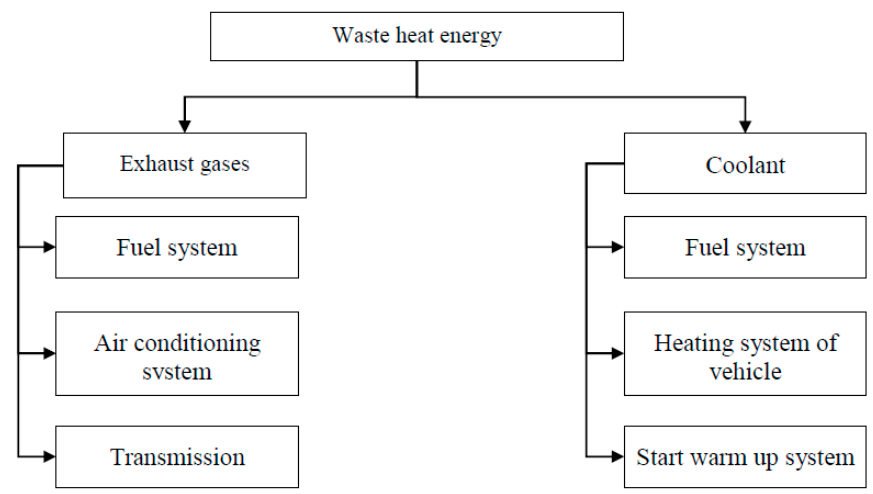
Figure 11. Heat recovery for cooling and heating. Source: developed by authors.